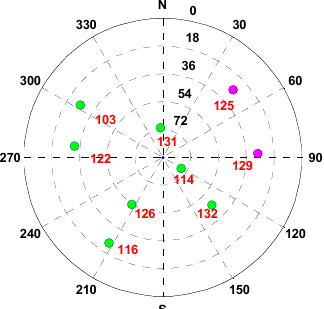
Figure 13. The sky plot of satellites for the epoch of 2000 s, in which green and magenta dots denote the blocked and visible satellites, respectively.